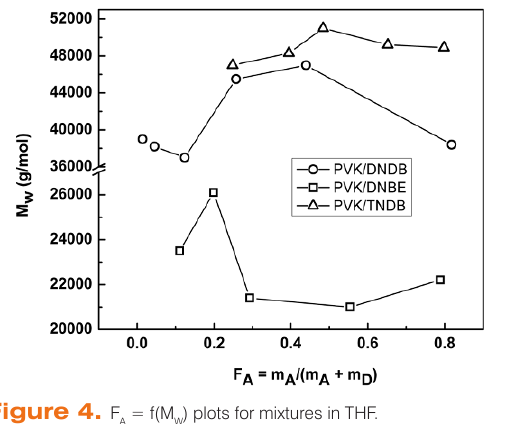
= f(M ) plots for mixtures in THF. A W